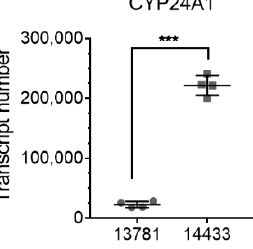
Figure 2. Absolute transcript number of CYP24A1 mRNA in the two cell lines 13781 and 14433 measured by absolute quantification RT-qPCR. Two-tailed t -test *** p < 0.001, N = 4.